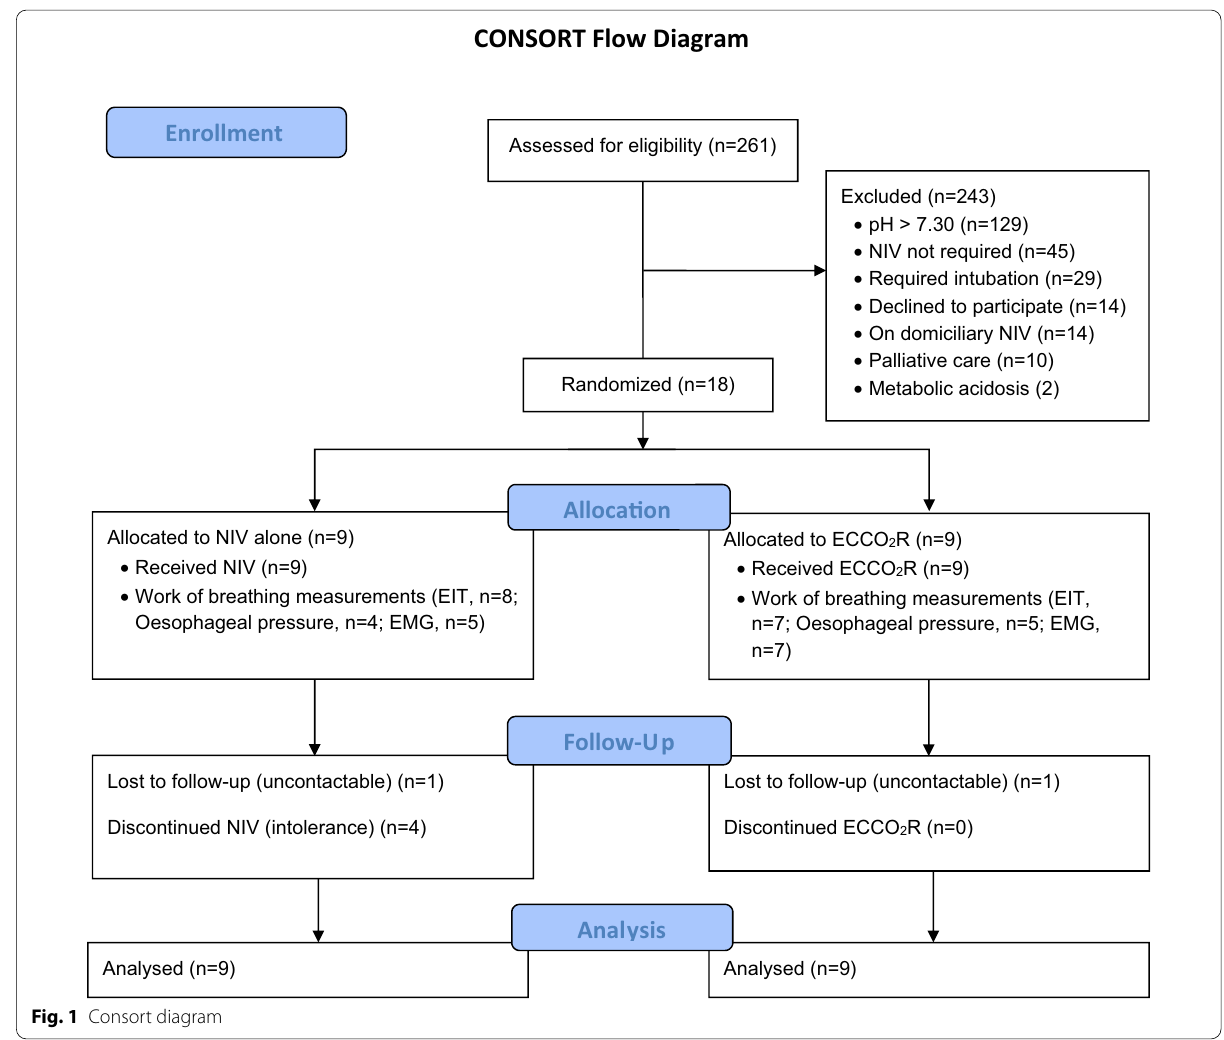
The discomfort and dyspnoea scores did not change between days 1 and 2 for NIV or ECCO 2 R (Fig. 4, Addi- tional file 3: Table